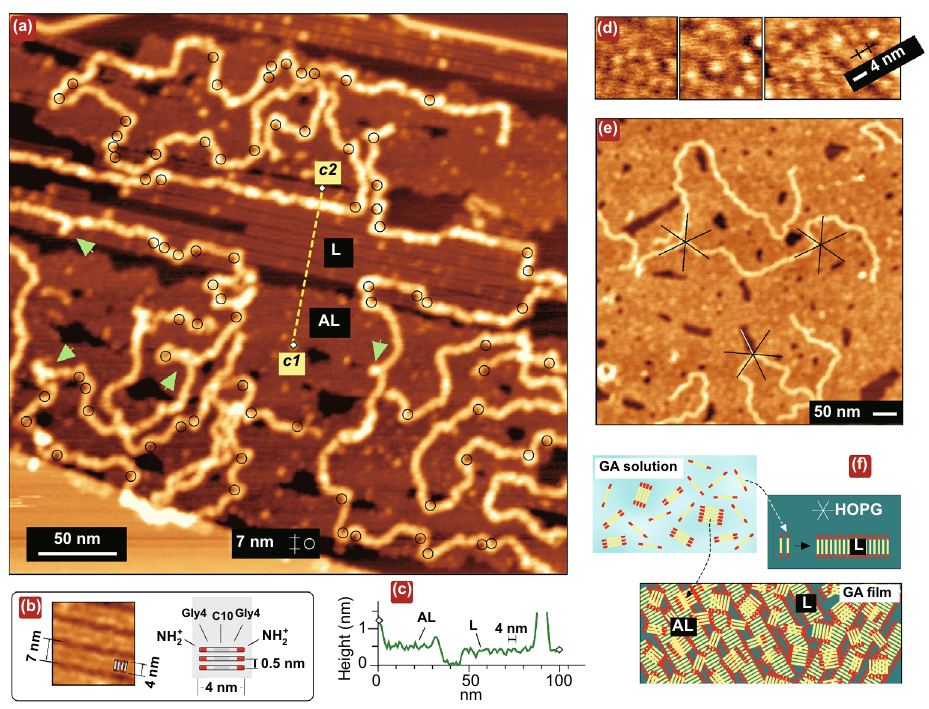
Fig. 2 AFM imaging of the two‑layer AL/L structure of GA film inducing either the projected or the template‑directed DNA conformations. a AFM topography image in air of pUC19 DNA on the incomplete GA monolayer with morphologies of the periodic lamellar epitaxial layer (L) and the uniform granular adlayer (AL). The scan size is 345 nm. The sites of the extreme curvature are marked by the black circles with 3.5 nm radius. The Y‑shaped protrusions are marked by the light green arrows. b The fragment of the lamellae image and the model of the molecular packing in lamellae (positively charged amino groups are shown by red). c The topography profile along the dashed line drawn between points c1 and c2 in (a). d Phase images of the granular adlayer demonstrating the grains polydispersity and a characteristic dimension. e AFM topogra‑ phy image in air showing the anisotropy of the pUC19 DNA orientation in the projected DNA conformation. Scan size 600 nm. f The scenario of growth of two‑layer (granular adlayer/lamellar sublayer) GA film in two stages from a polydisperse GA